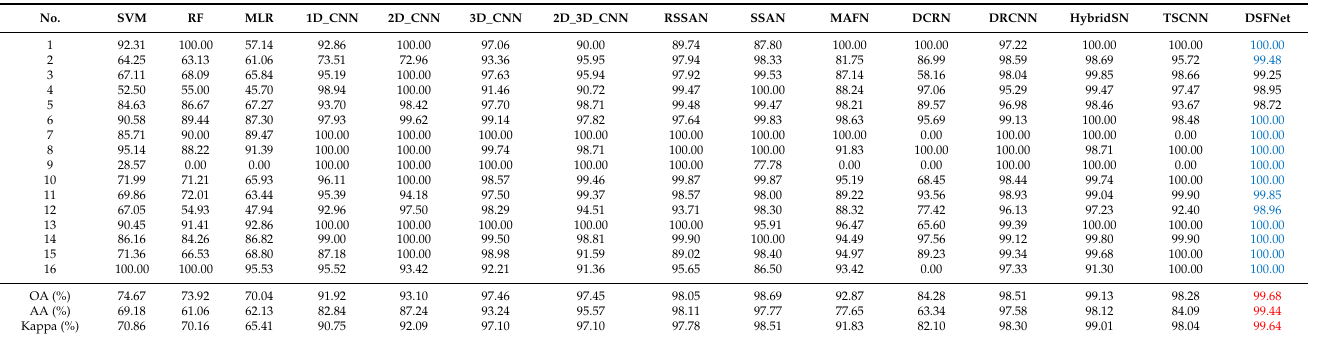
Table 7. Classification results on the IP dataset.